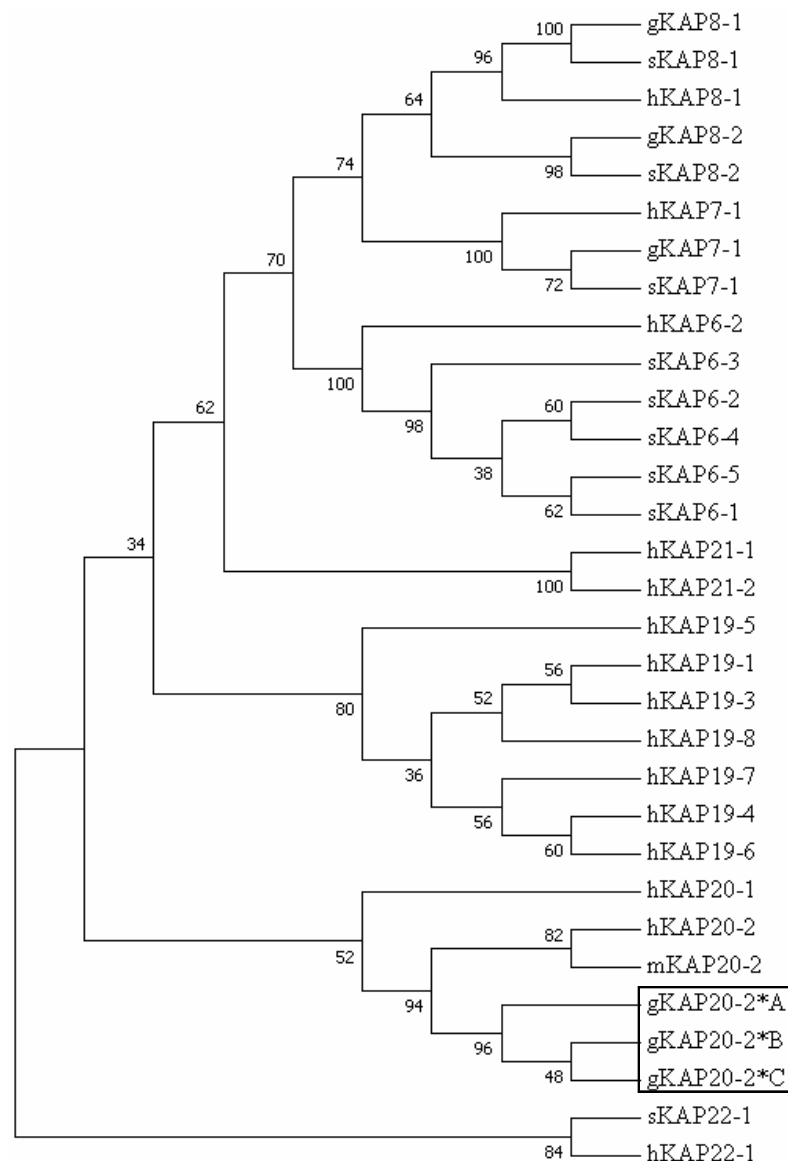
Figure 3. Maximum parsimony tree of the high glycine/tyrosine keratin-associated proteins (HGT-KAPs) identified in goats, sheep and humans, together with the mouse KAP20-2 sequence. The tree was constructed using the predicted amino acid sequences. The numbers at the forks indicate the bootstrap confidence values. The caprine KAPs are indicated with a prefix “g”, while the sequences of sheep, human, and mouse are indicated with “s”, “h” and “m”, respectively. The three newly identified goat KAP20-2 sequences are shown in a box, and the GenBank accession numbers for the other HGT-KAPs are: NM_001193399 (sKAP6-1), KT725832 (sKAP6-2), NM_181604 (hKAP6-2), KT725837 (sKAP6-3), KT725840 (sKAP6-4), KT725845 (sKAP6-5), AY510121 (gKAP7-1),